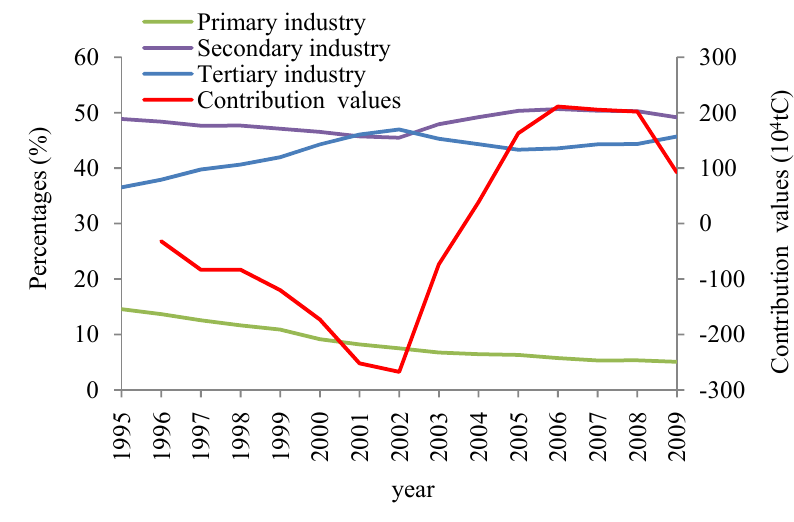
Figure 8. Change of industrial structures and contribution of industrial structure effect.